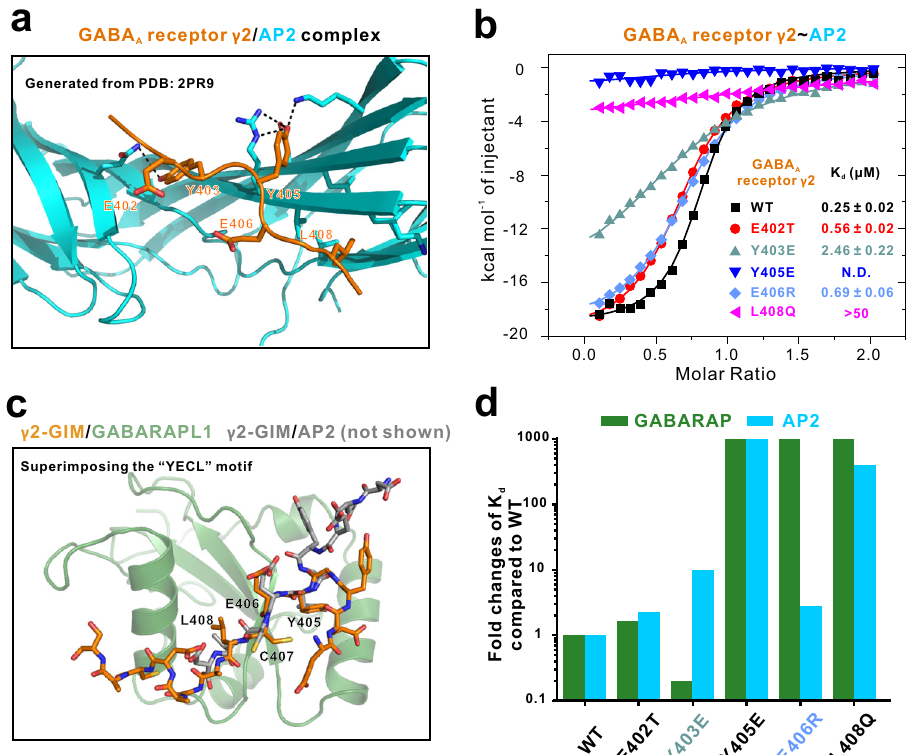
Fig. 3 Distinct molecular mechanisms regulating γ 2-GIM ’ s speci fi c interactions with GABARAP or AP2. a The ribbon representation model showing the overall structure of the previously reported AP2 – γ 2-GIM complex. The fi gure is generated using the previous reported peptide complex structure (PDB code 2PR9 28 ). In this drawing, AP2 is shown in cyan and γ 2-GIM is shown in orange. b ITC-derived binding curves comparing the binding af fi nities between AP2 and GABA A R γ 2-GIM or its fi ve mutant variants (E402T, Y403E, Y405E, E406R, and L408Q). c Compare the conformations of γ 2-GIM in complex with GABARAP or AP2 by superimposing the “ YECL ” motif. d Bar graph of fold changes of K d values compared to WT showing the impacts on binding resulting from mutations of key residues in the GABA A R γ 2-GIM. Titrations for WT and E406R mutant were performed three times; others were performed once. K d values are reported in Supplementary Table